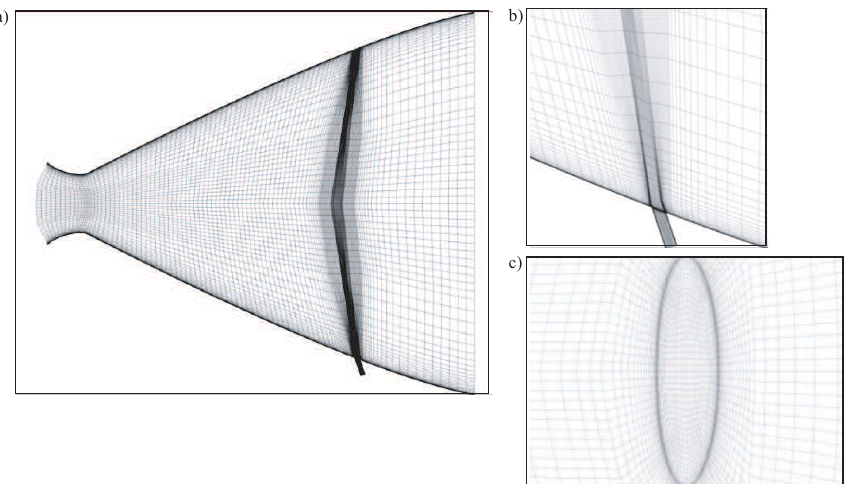
Figure 7. Computational mesh ( a ), mesh near injection port ( b ) and mesh in cross section of the injection port ( c ) with l j = 0.7, α j = 130 ◦ , d 2 / d 1 = 4.5, A ∗ / A a = 1. The computational meshes shown in Figures 8 and 9 correspond to nozzles with different area ratios. For injection, a pipe with an elliptical cross-section in plan or a converging–diverging nozzle with an elliptical outlet section is